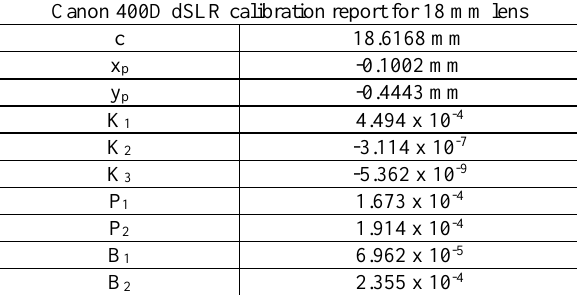
Table 4: Canon 400D Iwitness Calibration Report